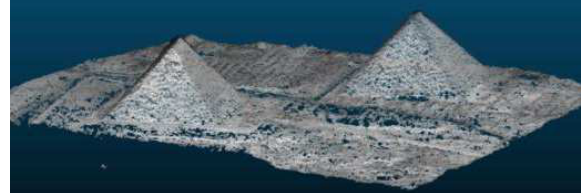
Figure 4: Point cloud generated with a Pleiades 1A tri-stereo on Giza Great Pyramid. The correlation step is based on QPEC / Medicis (Delvit et al, 2015).